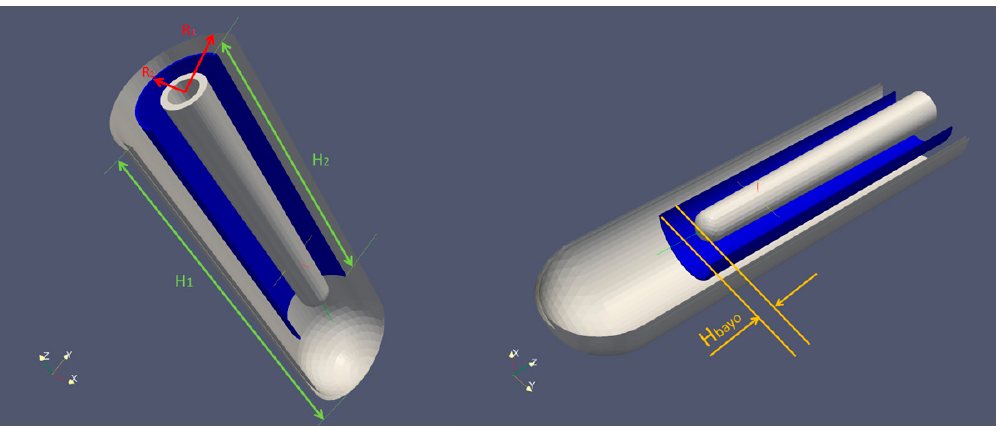
Figure 1. Geometry of the cooling target system.